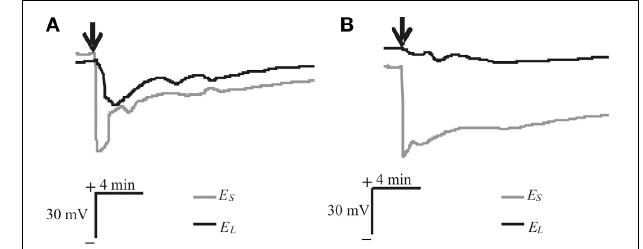
FIGURE 3 | Heat-induced changes in surface electrical potentials of steam and leaf. (A) VP propagated into leaf ( n = 17). (B) Only electrical reactions of small amplitude ( < 15mV) propagated into leaf ( n = 4). VP induced by heating tip of another leaf (arrow), and E S and E L , changes in electrical potential measured by electrodes on stem and lamina,